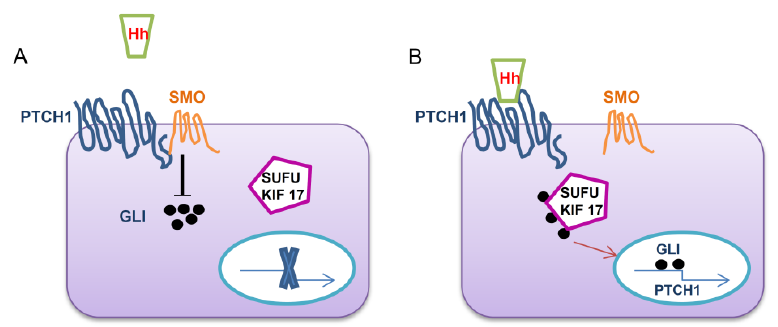
Figure 1. The Hedgehog signaling pathway mechanism. ( A ) In the absence of the Hh